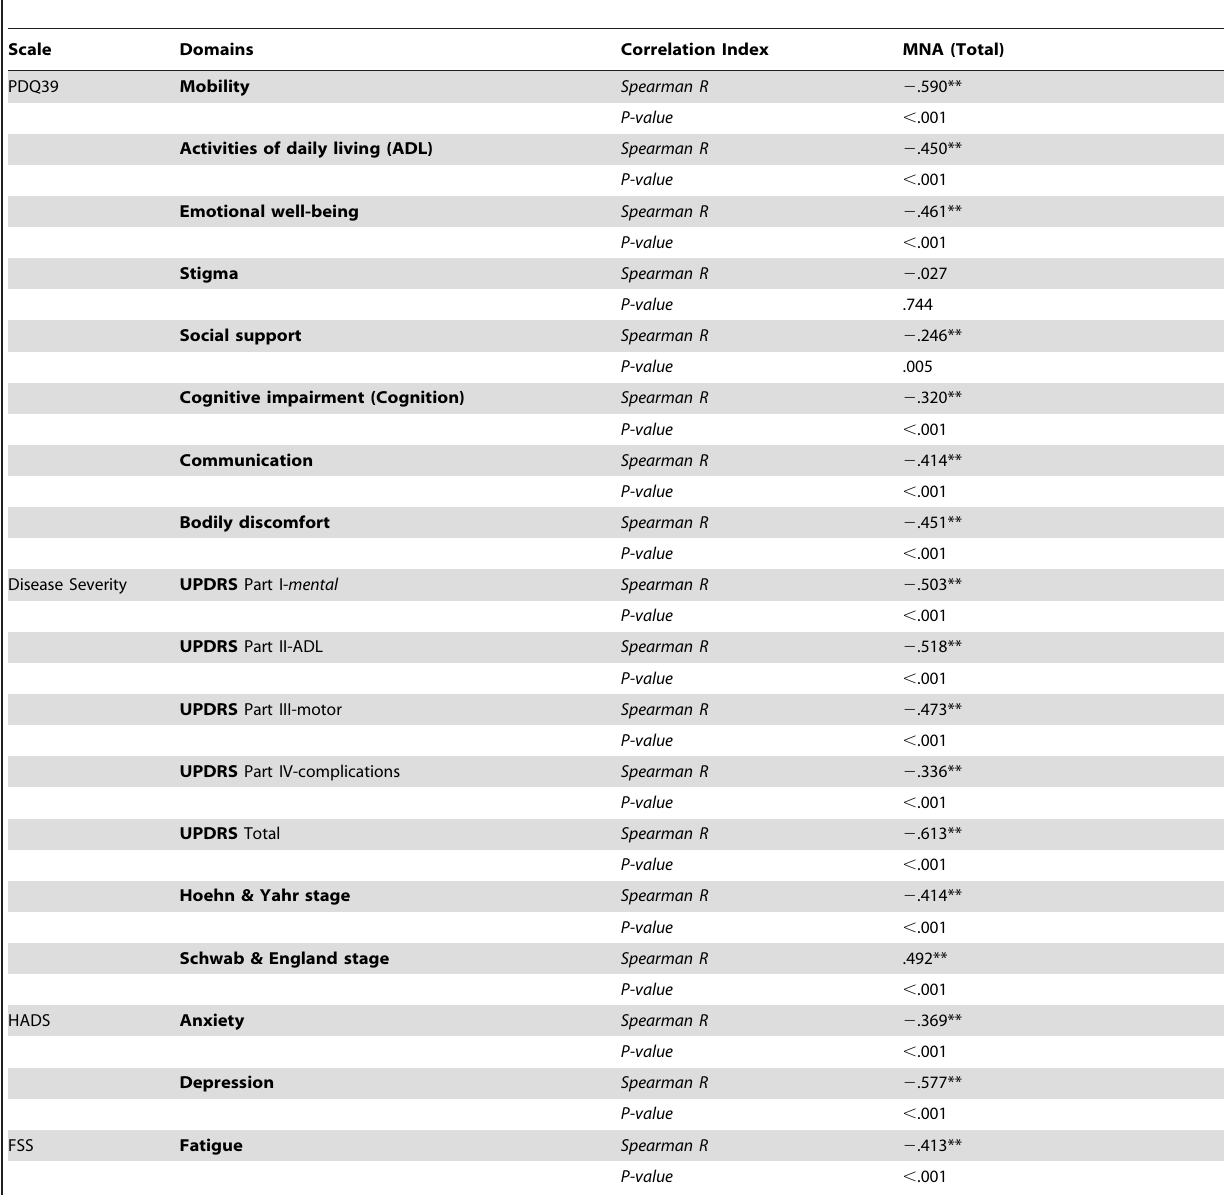
Table 3. Pearson correlation between the scores of different motor, psychiatric, fatigue and quality of life (PDQ-39) scales and nutritional status (MNA) in Parkinson’s disease (PD)